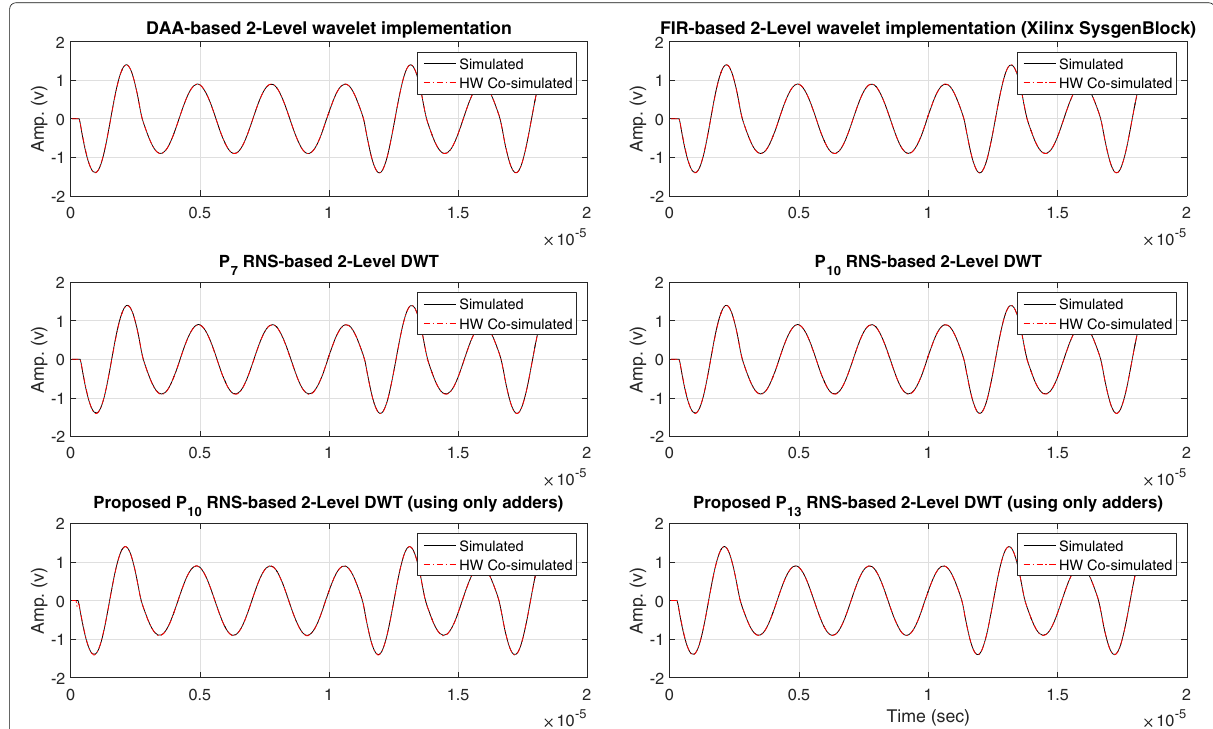
Fig. 11 The output of the two-level DWT when a pattern-based signal [4] is applied. It is used to extract the main features of the received